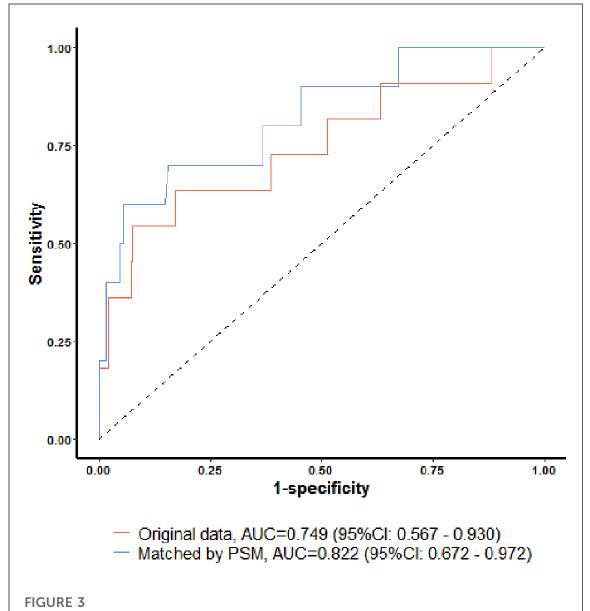
FIGURE 3 ROC curves on the rate of neonate transfer to the NICU for hypoglycemia treatment before and after